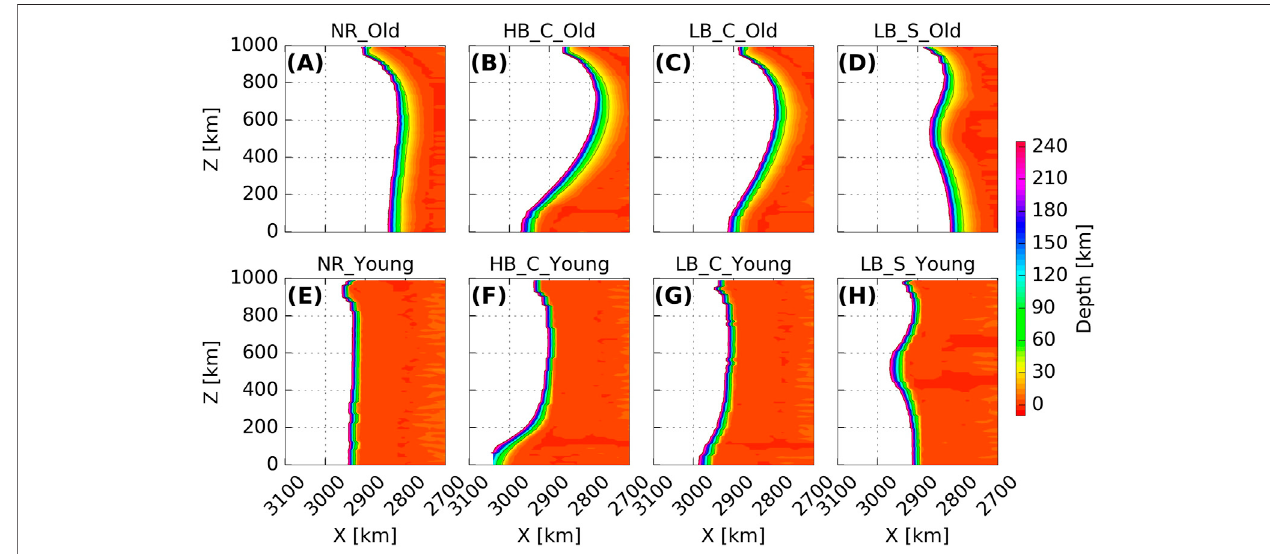
FIGURE 6 | Top-down view of fi nal plate top surface depth above 250 km for Old (A-D) and Young (E-H) models. Coloured by depth, thereby providing an illustration of the along-strike variations in slab dip. Note that the X and Z axes are scaled differently.